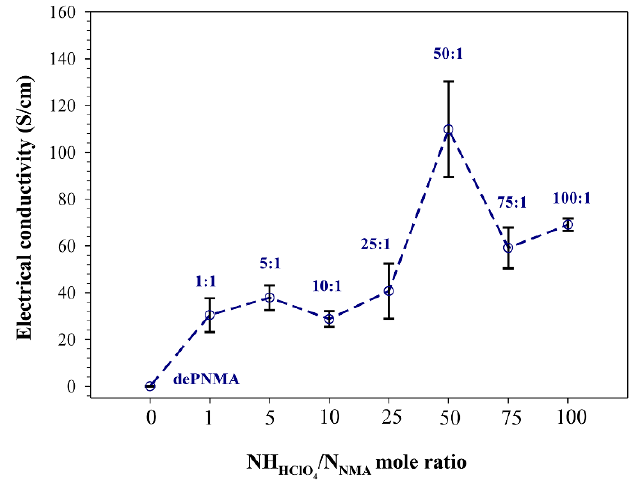
Figure 7. σ values of dePNMA and HClO 4 doped PNMA at di ff erent doping mole ratios N HClO /N (cid:2898)(cid:2897)(cid:2885) . (Each average value was obtained from 3 samples × 3 repeated measurements).